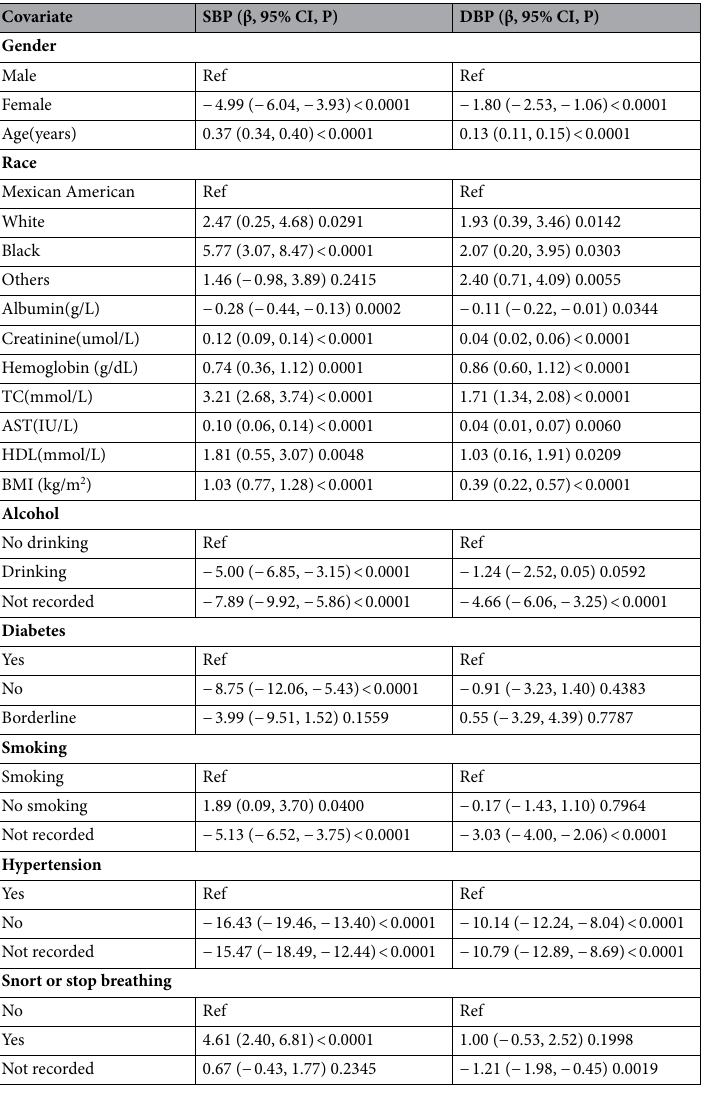
Table 2. Univariate analysis for SBP and DBP. CI confidence interval, Ref reference, TC total cholesterol, BMI body mass index, AST aspertate aminotransferase, HDL high-density lipoprotein, SBP systolic blood pressure, DBP diastolic blood pressure.